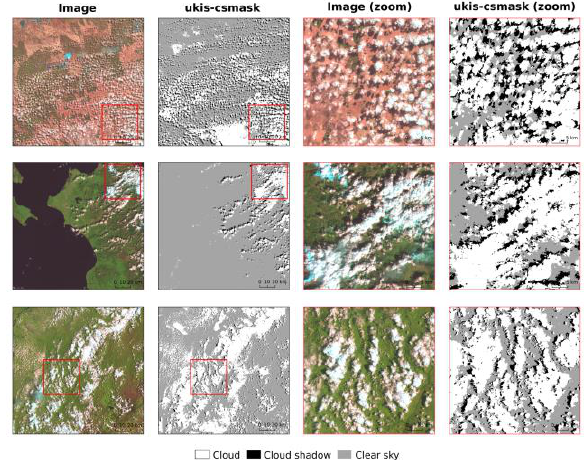
Figure 5. ukis-csmask predictions on Landsat-9 images acquired over Australia (first row), Greece (second row) and Colombia (third